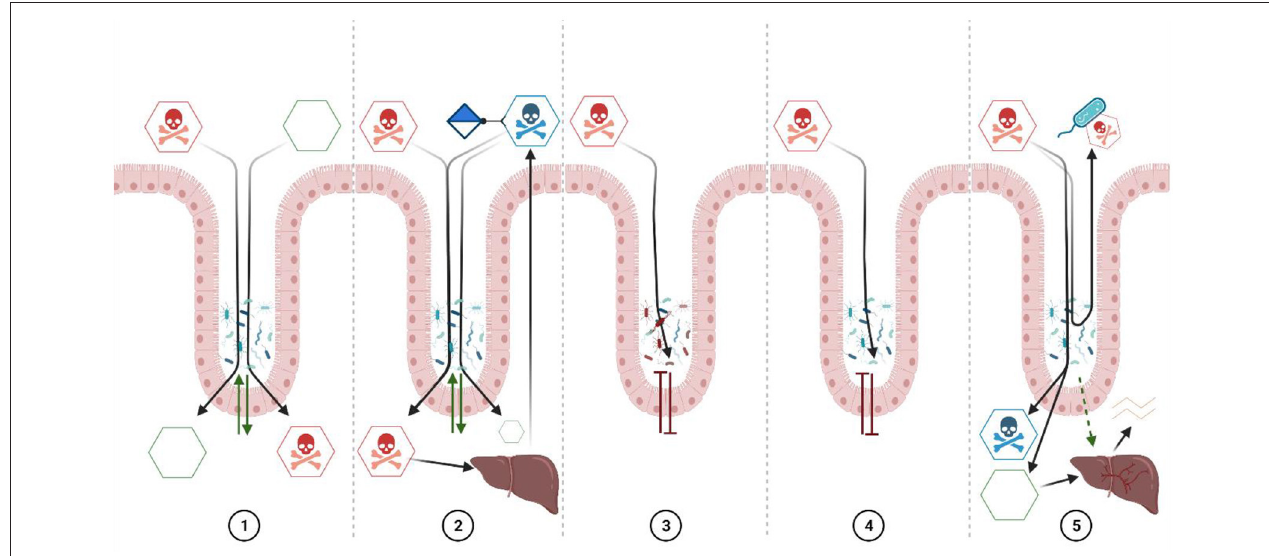
FIGURE 1 | Xenobiotic interaction with the intestinal microbiota. 1. Xenobiotics not affected by oral cavity, stomach, and small intestine digestion, or poorly adsorbed, are displaced to the distal small intestine and cecum by peristalsis, and the microbiota residing in the large intestine may directly metabolize those partitioned through the intestinal wall from the blood. 2. Due to the non-polar nature of most xenobiotics, they are easily absorbed by the intestinal tract and subsequently transported through the bloodstream to the liver where some xenobiotics are oxidized, forming conjugates (with sulfates, glucuronic acid or glutathione) that can be excreted by the bile and metabolized by the microbiota which, in turn, transforms these conjugates into non-polar molecular conjugates of low molecular weight with low toxicity that are adsorbed again; however, the microbiota can also deconjugate these compounds and “release” the xenobiotic again. 3. Some xenobiotics can affect the gut microbiota, either by affecting specific taxonomic groups or favoring others. The function of the intestinal microbiota is affected and, with it, the symbiotic relationship with the host. 4. Although some xenobiotics do not affect the abundance of gut microbiota members, they can affect the function of the microbiota. Some changes may occur in the activity of endogenous metabolites or the general metabolic capacity of the microbiota, also affecting the symbiotic relationship with the host. 5. The intestinal microbiota could induce an enzymatic response at the liver tissue level, increasing the host’s detoxification capacity. Also, the microbiota can produce active and inactive variants of the xenobiotic, which can be metabolized by liver tissue. Finally, some microbiota bacteria inactivate the xenobiotic by direct interaction (binding) on the cell surface, decreasing the adsorption of the xenobiotic. However, there could be multiple additional mechanisms that have yet to be elucidated. Based on Claus et al. (8) with modifications and insertions. Created with